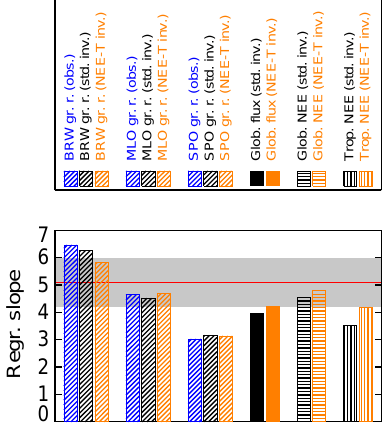
Figure 4. Effective large-scale inter-annual climate sensitivities (PgCyr − 1 K − 1 ) calculated from the standard inversion (black), from the NEE– T inversion (orange), or from observed atmospheric CO 2 (blue). The sensitivities refer to inter-annual variations in the CO 2 growth rate at three selected atmospheric stations (Point Bar- row, Alaska (BRW), Mauna Loa, Hawaii (MLO), and the South Pole (SPO), diagonally hashed), in the global total CO 2 exchange (solid bars), in the global terrestrial NEE (horizontally hashed), or in tropical NEE (25 ◦ N–90 ◦ S, vertically hashed), all regressed against inter-annual variations in air temperature averaged across tropical land (25 ◦ N–25 ◦ S) over 1985–2016. The red line surrounded by grey shading denotes the result 5 . 1 ± 0 . 9PgCyr − 1 K − 1 by Cox et al. (2013), even though it is calculated in a slightly different